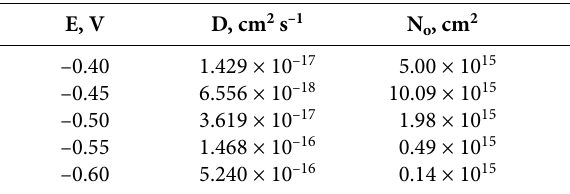
Table 1 . Experimental data on the electrodeposition of Fe on a Pt electrode E, V D, cm 2 s –1 N o , cm 2 –0.40